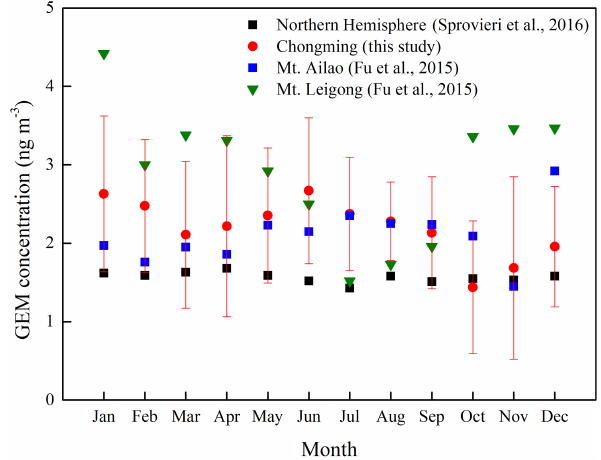
Figure 3. Monthly variations of GEM concentration at remote sites in